Question: Does the figure show an increasing or a decreasing trend?
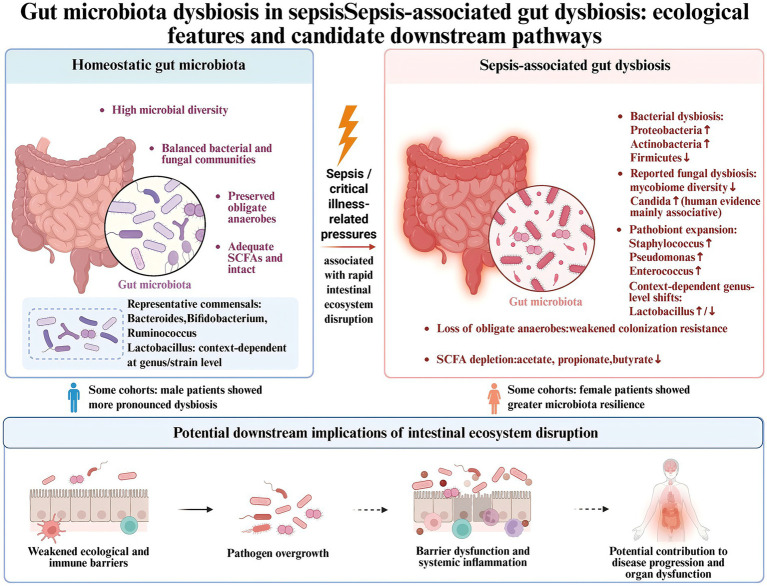
Answer: increasing